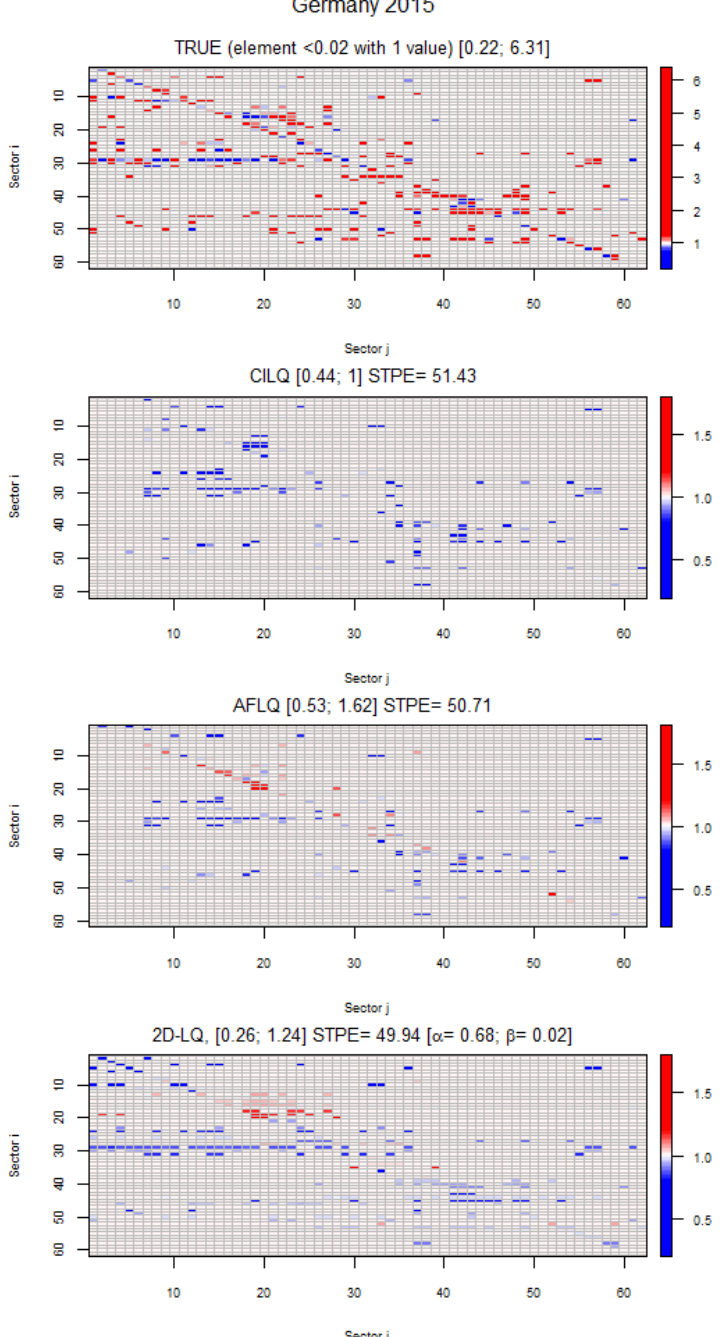
Figure 5. Projections of technical coefficients via LQ versus ideal rectifications (Germany). Source: internal based on Eurostat data [naio_10_cp1700].